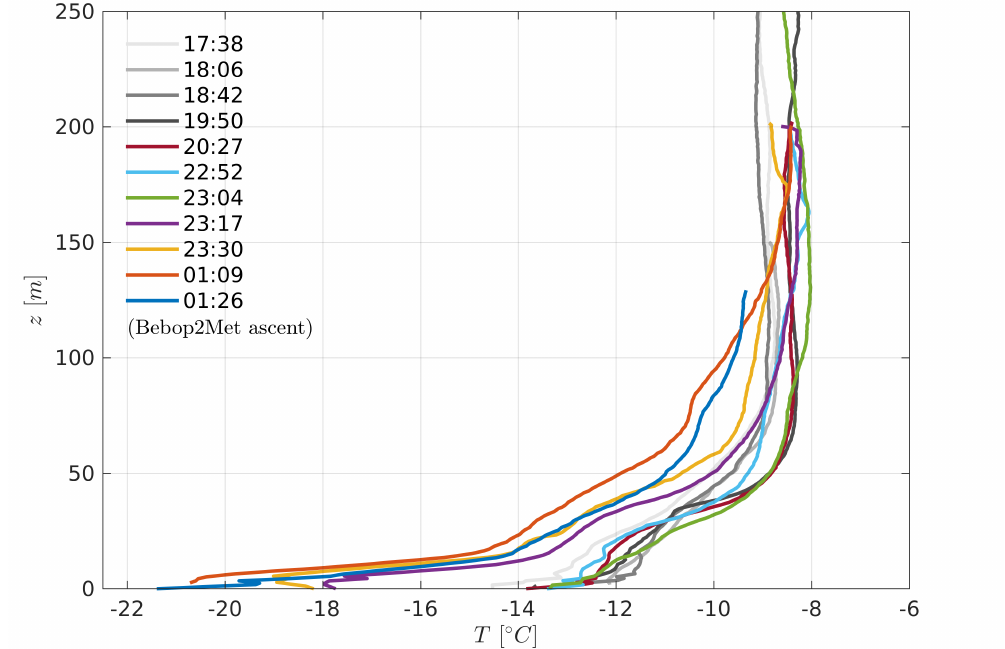
Figure 10. Evolution of the temperature profile during the night of 26 to 27 February, observed by the Bebop2Met UAV during ascent. The times in the legend refer to the mean times of each individual